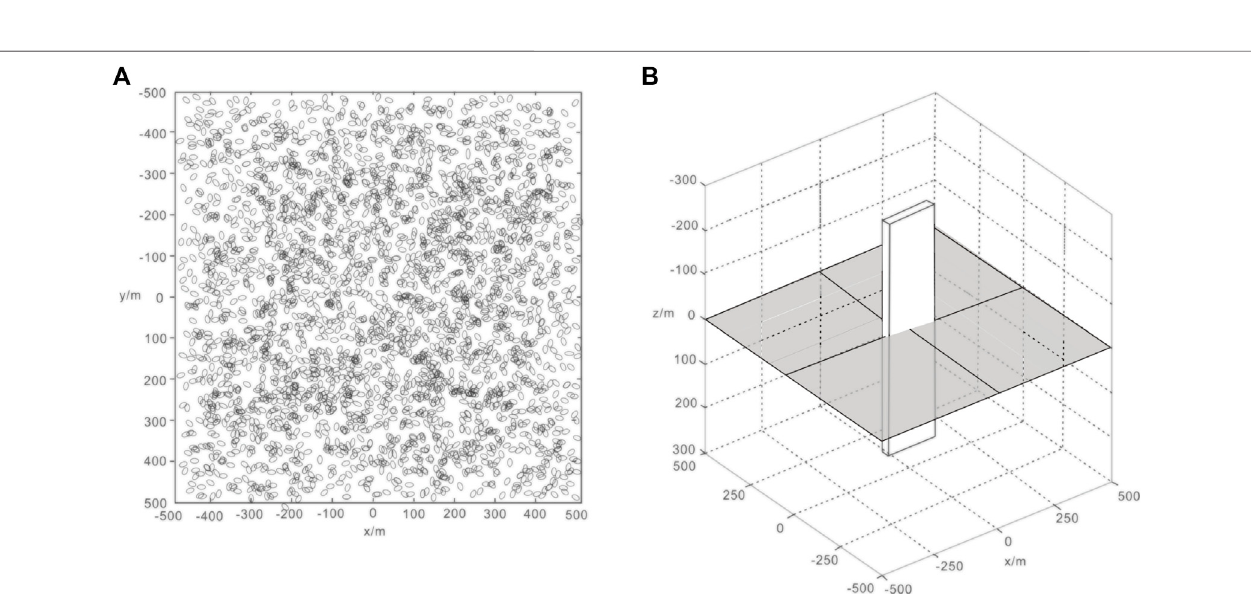
FIGURE 5 | Contour map of the gravity anomaly on the observation plane at z = 0